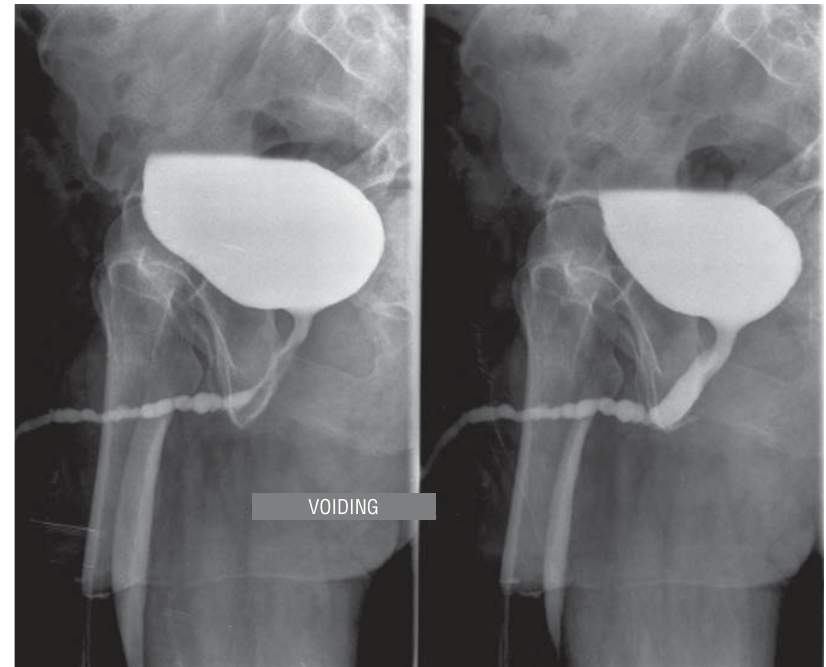
Figure 4 - Panurethral stenosis. Voiding